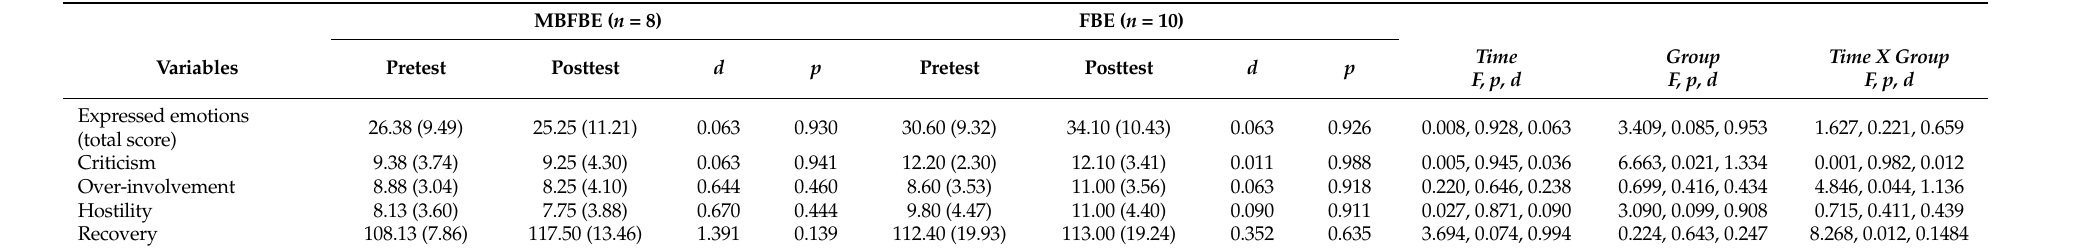
Table 4. Measures over time for the MBFPE and FPE groups on outcomes of young adults in recovery (caregiver burden as covariates). MBFBE ( n =